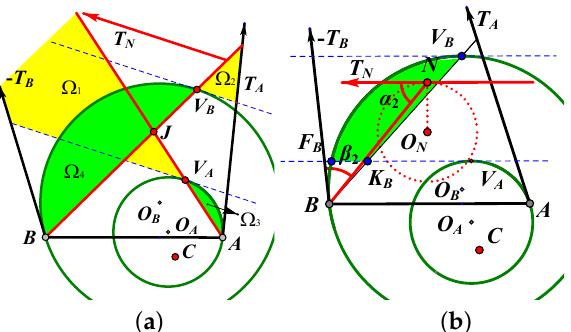
Figure 12. Inserting the first new data set { N , T N , O N } when C / ∈ G and C is in both curvature